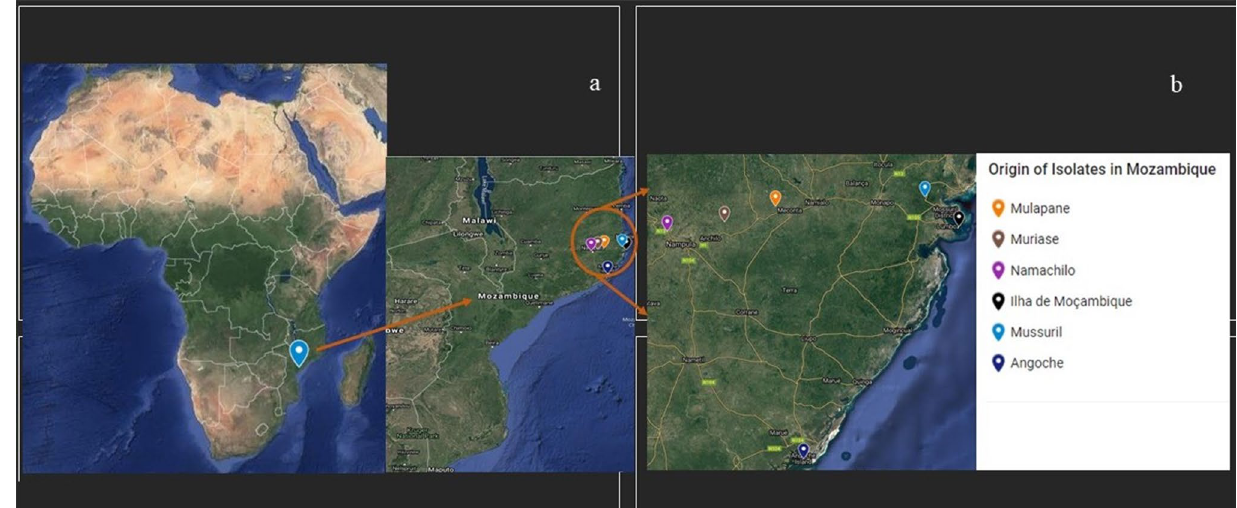
Figure 1. A map showing ( a ) the geographic origins of the cowpea isolates from Mozambique that were used in this study. The sampling locations are ( b ) magnified and indicated by means of coloured markers/pointers that are defined using legends. The map was created using Google Maps (https:// www. google. com/ maps) by adding markers corresponding to the GPS coordinates of the sampling locations. The resulting map was cropped to obtain the areas consisting of the sampling locations used in this study. The detailed map is available at https:// www. google. com. gh/ maps/@- 14. 56601 44,38. 69438 58,6. 5z/ data= !4m2!6m1!1s15W ALAjI oz1lm- E2- u4QD4 MatOl cDYdMD? hl= en (last accessed on 8th January,